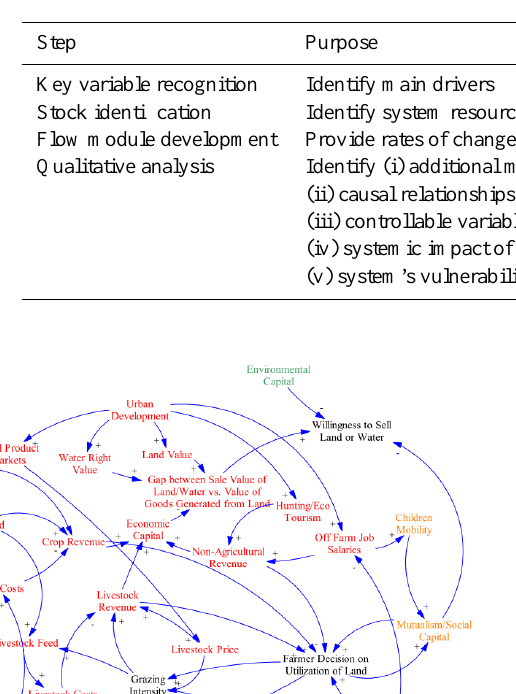
Table 2. Procedure for building SFD using CLD (from Mirchi et al., 2012).